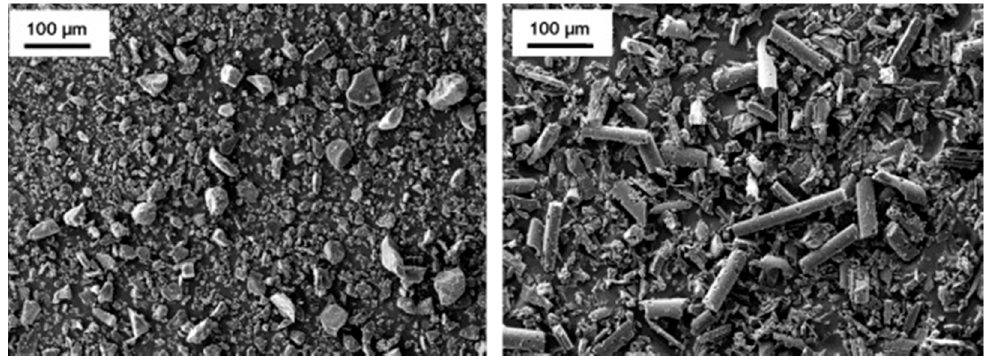
Figure 23. SEM images of activated particulate activated carbon ( left ) and pulverized activated carbon fibers ( right ). Adapted from [179].